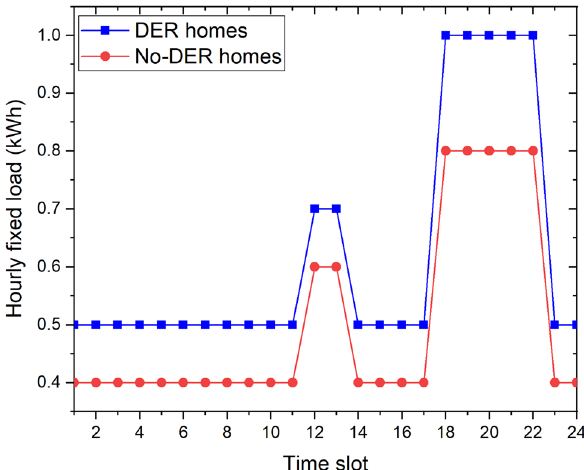
Figure 3. Hourly fixed loads of DER homes and no-DER homes.